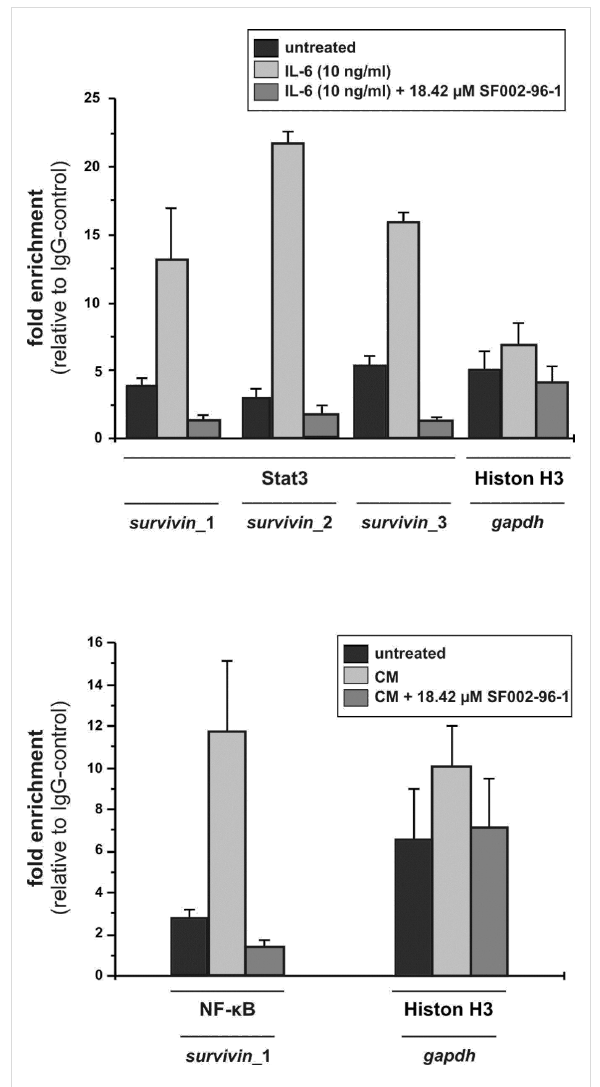
Figure 5: Effect of SF002-96-1 on Sat3 and NF- κ B binding to the survivin promoter in Colo 320 cells analyzed by ChIP assay. Colo 320 cells were pretreated with 18.42 µM (5 µg/mL) SF002-96-1 for 1 h before stimulation with 10 ng/mL IL-6 (for Stat3) and 10 ng/mL TNF- α , 5 ng/mL IL-1 β (for NF- κ B) for 30 min. Chromatin was cross-linked and immunoprecipitated using antibodies against Stat3, NF- κ B p65, ace- tylated histone 3 (H3K9Ac) or rabbit IgG. DNA isolated from immuno- precipitates or from total chromatin preparation before